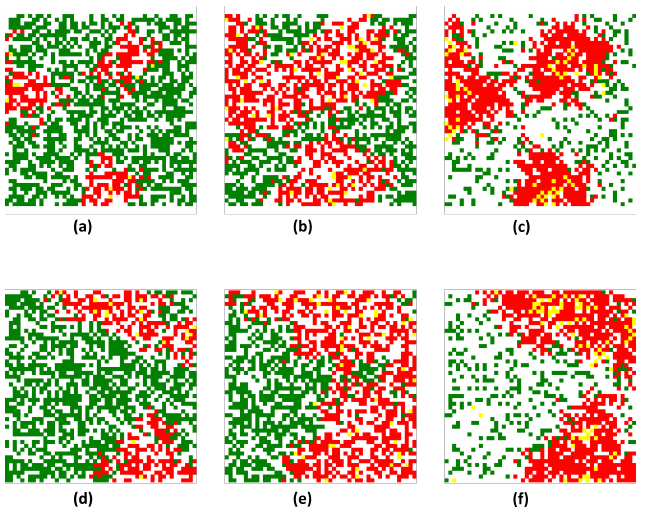
Figure 10. Regeneration of spatial information algorithm, the example result: (a),(d) population before the switch, (b)(e) population at threshold without a switch, (c)(f) population regenerated from (a)(d) after a switch